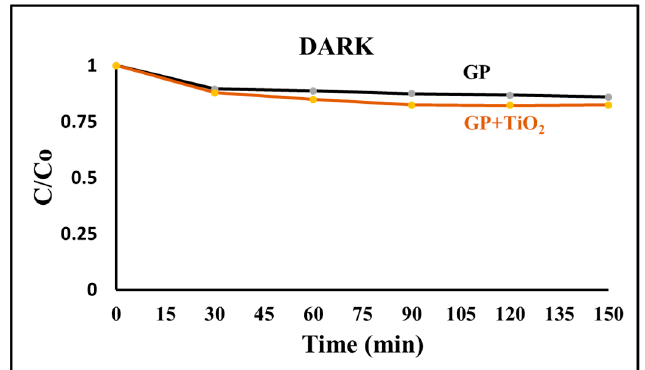
Figure 8. Adsorption–desorption equilibrium of methylene blue (MB) on GP and GP + TiO 2 surfaces at varying times under dark conditions.